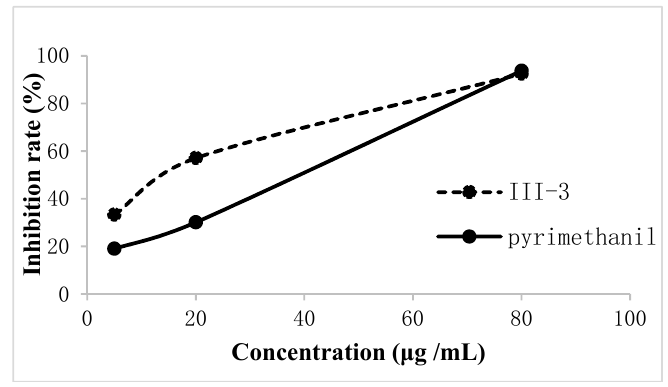
Figure 4. Effect of compound III-3 on the spore production of B. cinerea (FGA).